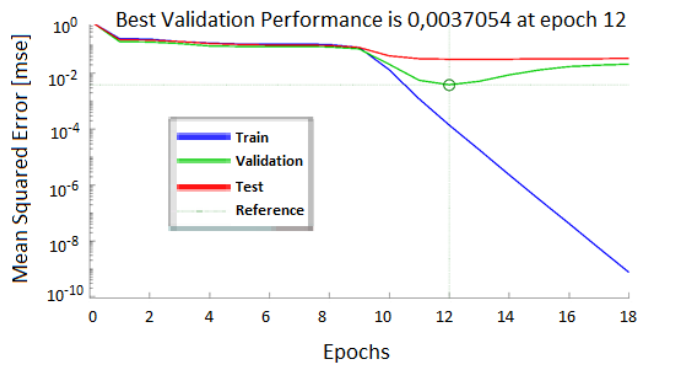
Figure 12. Training efficiency for NET1_HF neural network.